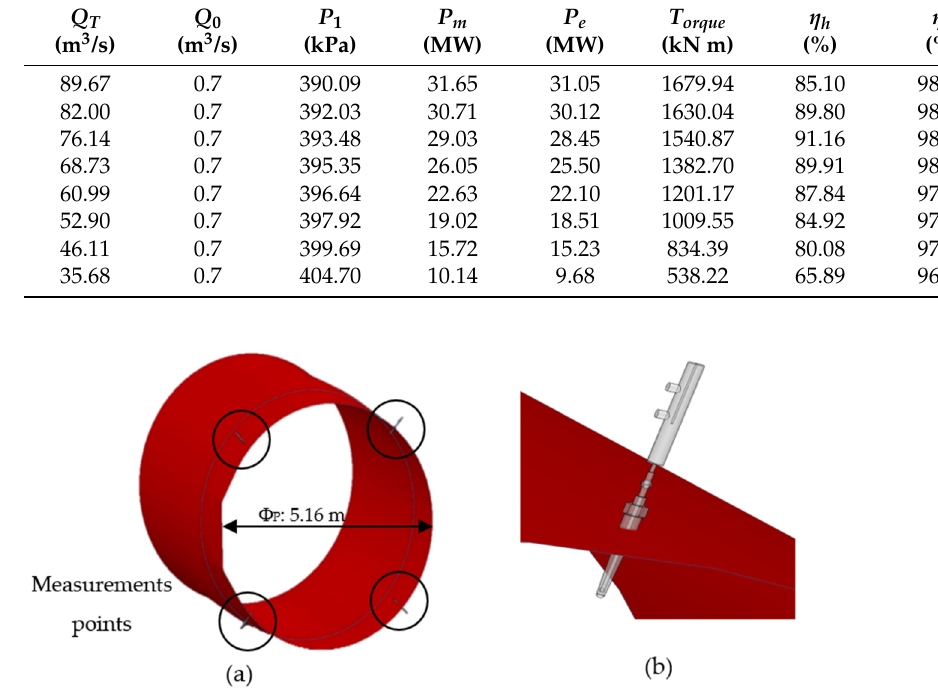
Figure 2. Measurement system, high-pressure section: ( a ) general view, ( b ) upper-right probe and manifold, zoom.